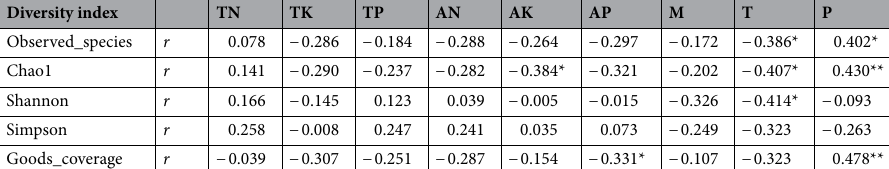
(Supplementary Table S2). The Monte Carlo permutations results at the OTU level showed that the total nitrogen (TN), total phosphorous (TP), and available nitrogen (AN) soil contents had a highly significant influence on rhizosphere prokaryotic communities ( p < 0.001), whereas the total potassium (TK) and available phosphorus (AP) contents had a significant influence ( p < 0.05) (Table 3). These findings suggest that precipitation, tem- perature, soil water and nitrogen, phosphorus, potassium content represent important contributing factors for regulation of the rhizosphere prokaryotes.